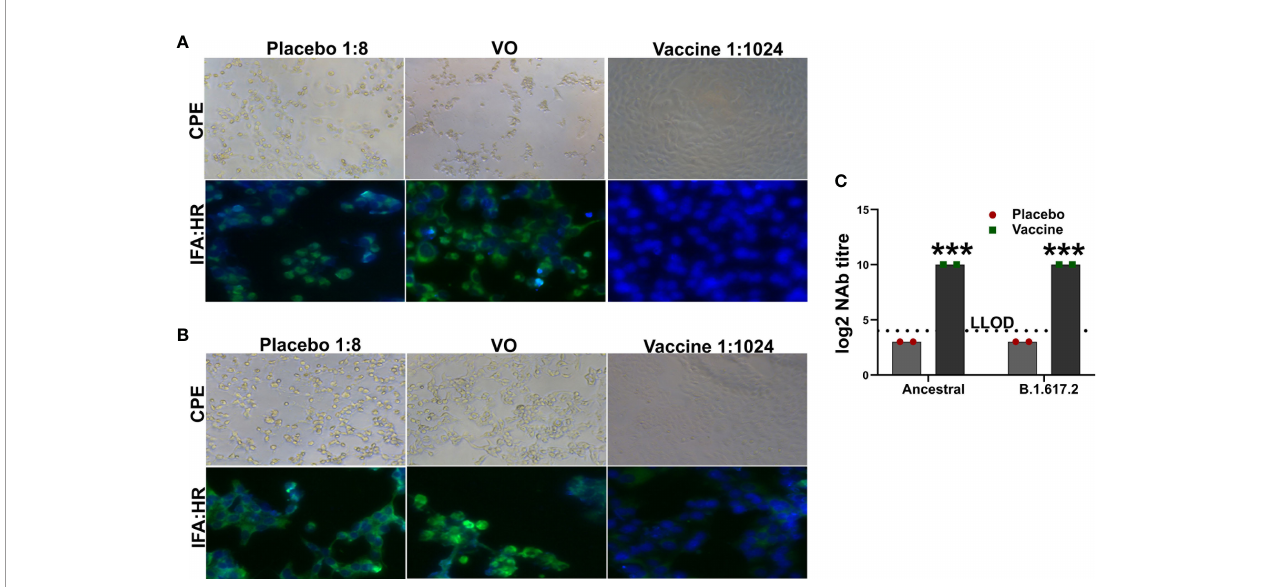
FIGURE 2 | Assessment of neutralizing antibody titer. The inhibition of viral replication by the immune mice sera was evaluated by IFA using HR antibody. IFA images showing neutralization of (A) ancestral SARS-CoV-2 and (B) B.1.617.2 delta variant. (C) The log2 NAb titer has been shown in the right panel. Dashed line represents lower limit of detection (LLOD). Data information: The data was analyzed by two-way ANOVA using S ̌ ı ́ da ́ k ’ s multiple comparisons test. Data presented as mean ± SEM at 95% CI. ***p <